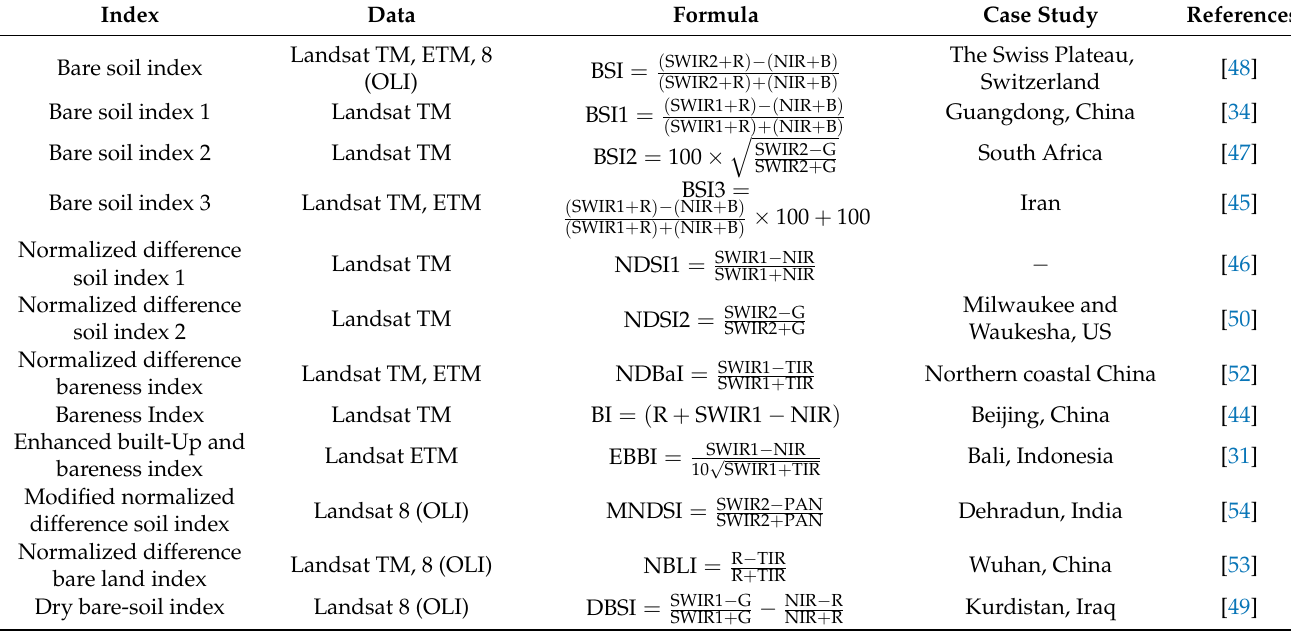
Table 1. Bare soil indices derived from Landsat